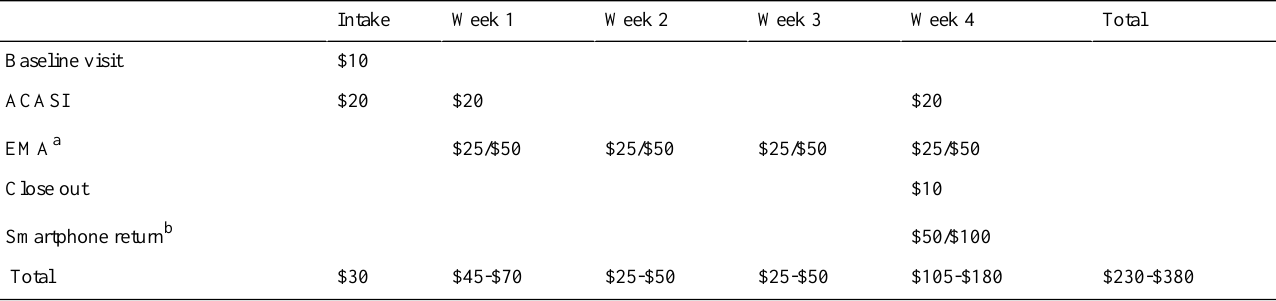
Table 1. Participant reimbursement/visit schedule (in